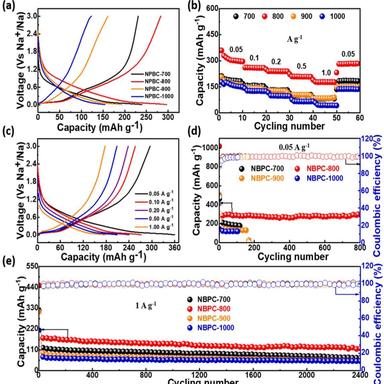
(a) GDC profiles of NBPC-700, NBPC-800, NBPC-900, and NBPC-1000 at a current density of 0.05 A/g. (b) Rate performance of NBPC-700, NBPC-800, NBPC-900, and NBPC-1000 at different current densities from 0.05 to 1 A/g. (c) GDC profiles at different current densities from 0.05 to 1 A/g of NBPC-800. Cycling performances of NBPC-700, NBPC-800, NBPC-900, and NBPC-1000 at a current density of (d) 0.05 A/g and (e) 1 A/g.